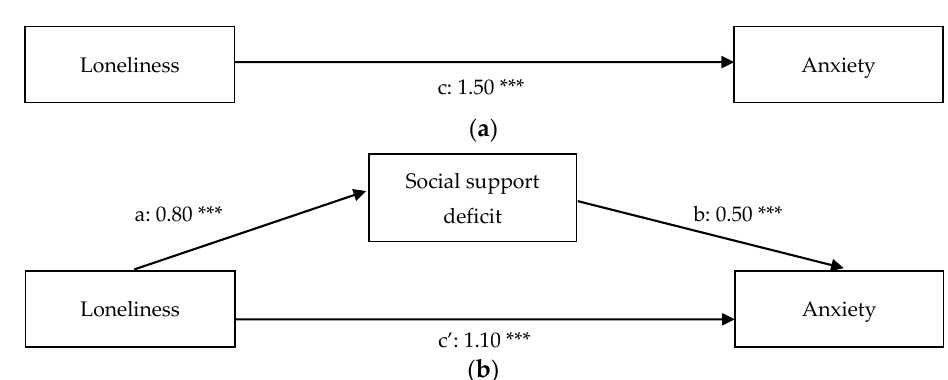
Figure 1. ( a ) Total relationship between loneliness and anxiety. ( b ) Mediation of the relationship between loneliness and anxiety. *** p < 0.01.